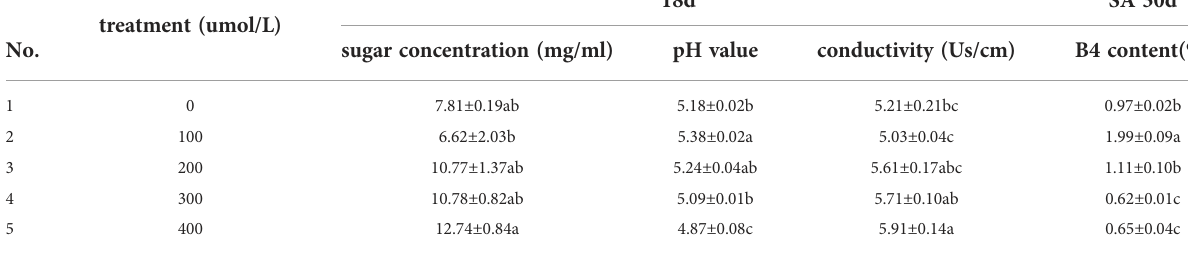
TABLE 1 The effect of SA elicitor on the growth of callus of P. chinensis